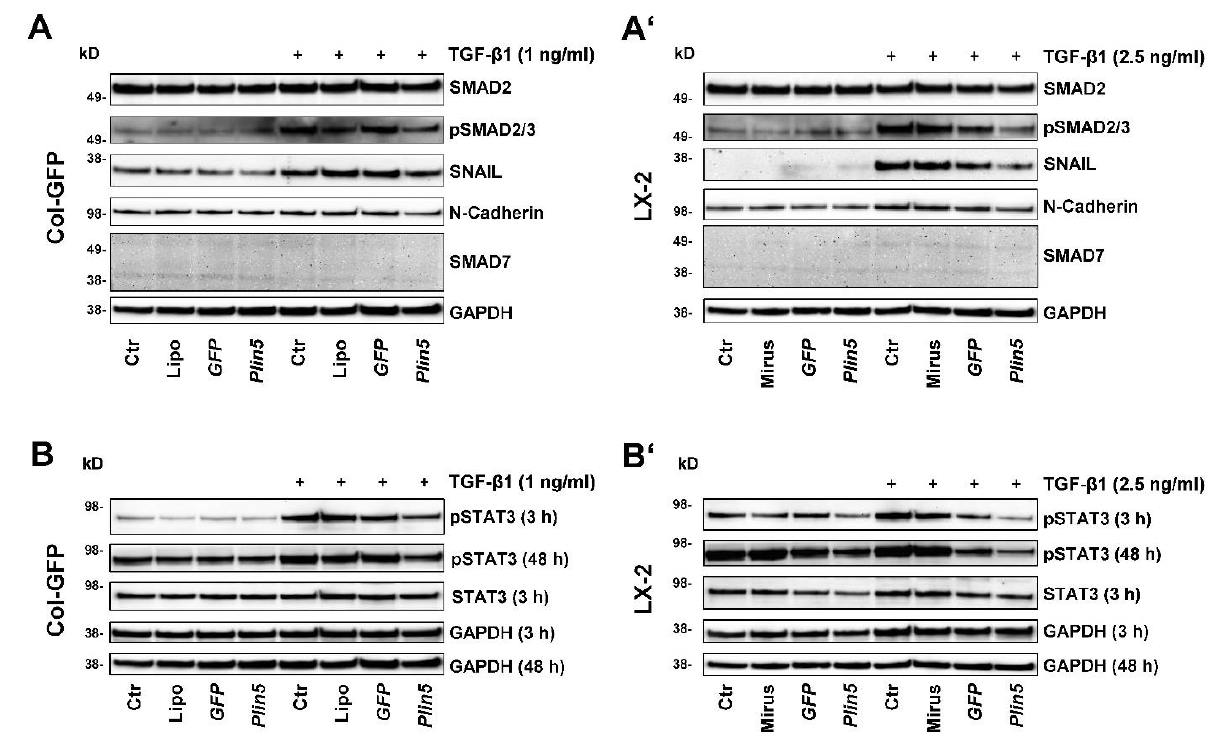
Figure 4. PLIN5 overexpression attenuates TGF- β 1 signal transduction and downstream target expression via SMAD2/3 signaling pathway and further inhibits the activation of STAT3. Western blot analysis of Plin5 transfected Col-GFP and LX-2 cells stimulated with TGF- β 1 for indicated time intervals (Col-GFP, 1 ng/mL; LX-2, 2.5 ng/mL). ( A , A’ ) show the expression of phosphorylated SMAD2/3 and total SMAD2 after 48 h stimulation, as well as the expression of the downstream targets SNAIL, N-Cadherin, and SMAD7. ( B , B’ ) depict the phosphorylation of STAT3 at Tyr705 after stimulation with TGF- β for 3 h and 48 h and unstimulated and total STAT3 after 3 h stimulation. All experiments were performed in triplicate. Ctr, control; Lipo, Lipofectamin.